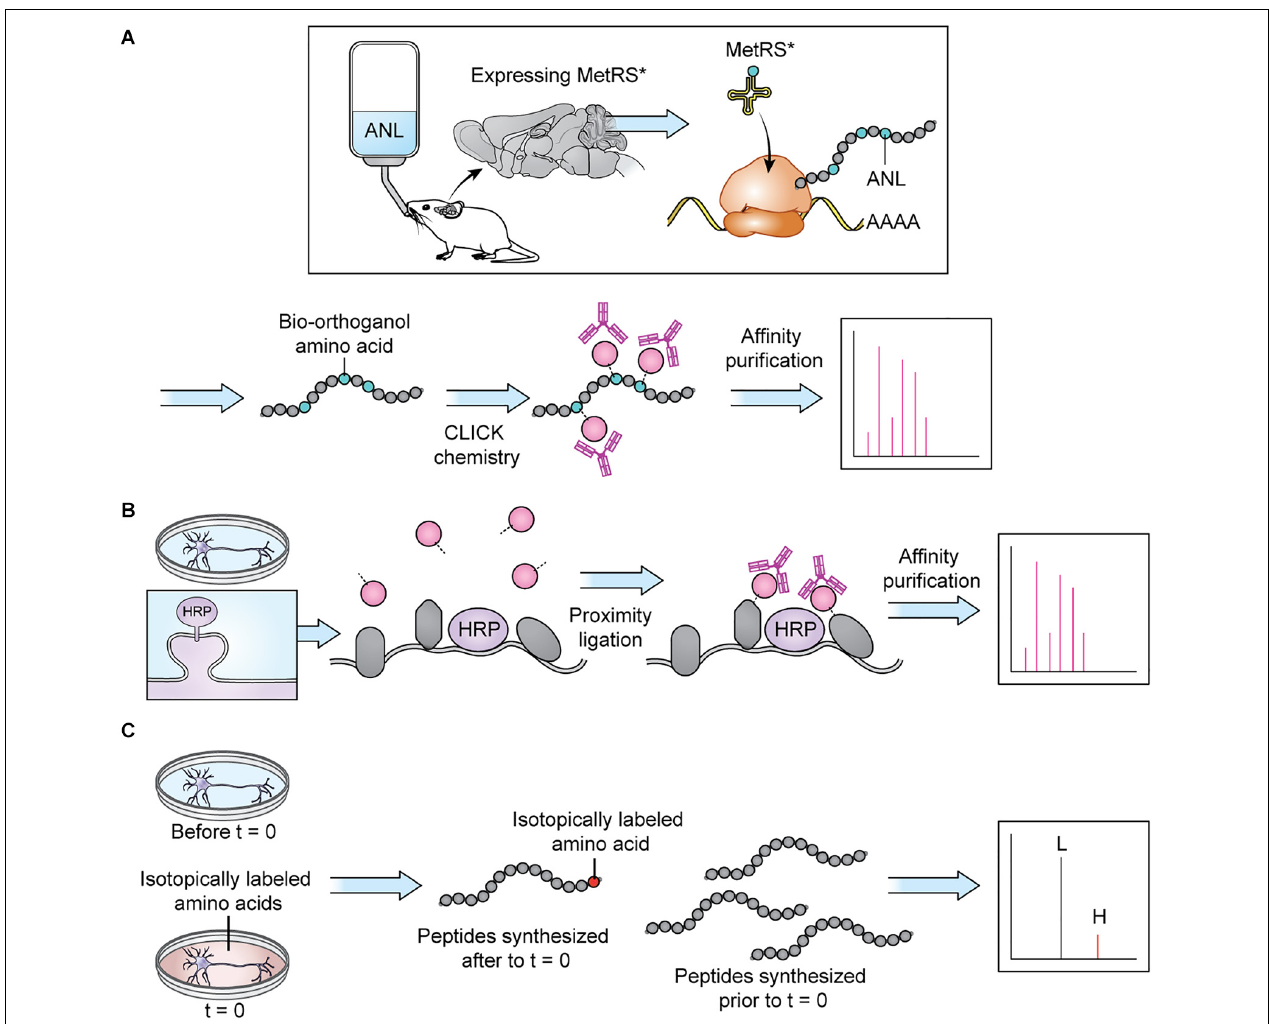
FIGURE 3 | Protein tagging techniques allow MS analysis of specific proteomes. (A) BONCAT: a modifiable bio-orthogonal amino acid (here: ANL) is incorporated into a newly synthesized protein via a mutant methionine transferase. During sample preparation, the bio-orthogonal amino acid is modified via CLICK chemistry to permit addition of a small molecule permitting affinity purification prior to MS. Stochastic orthogonal recoding of translation (SORT) operates by similar principles. For in vivo applications, the bio-orthogonal amino acid can be introduced in the animal’s diet. Panel adapted from Alvarez-Castelao et al. (2017). (B) Proximity ligation: An enzyme (here: HRP) is targeted to a specific cellular locale where it catalyzes reactions allowing small molecule tagging of nearby proteins. Tagged proteins are then affinity purified before MS. In cell culture applications, the small molecule can be introduced in the cell culture media. Panel adapted from Loh et al. (2016). (C) SILAC: an isotopically labeled amino acid is incorporated into a newly synthesized protein, causing a shift in mass visible on m/z spectra, allowing spectra of newly synthesized peptides (H) to be distinguished from spectra of peptides synthesized prior to delivery of the isotopically labeled amino acids (L). In cell culture applications, the isotopically labeled amino acids can be introduced in the cell culture